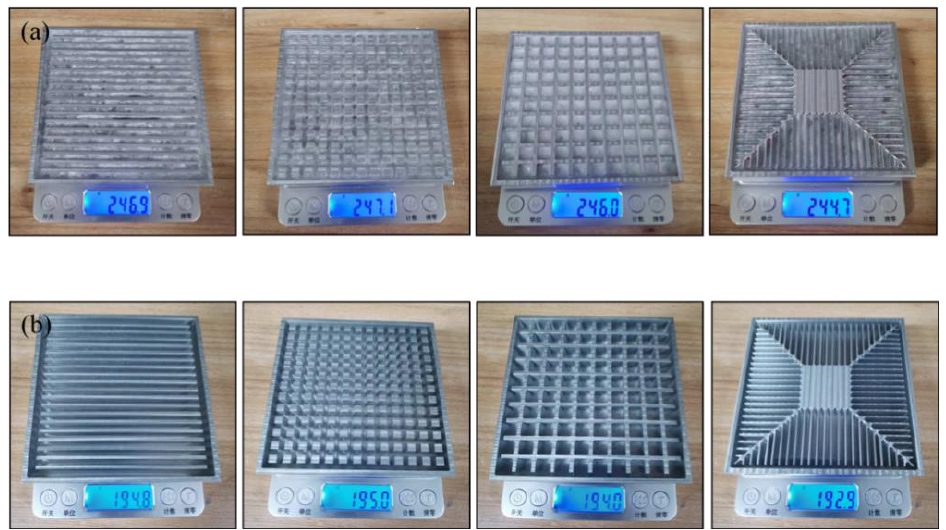
Figure 2. DSC curve of the paraffin wax.